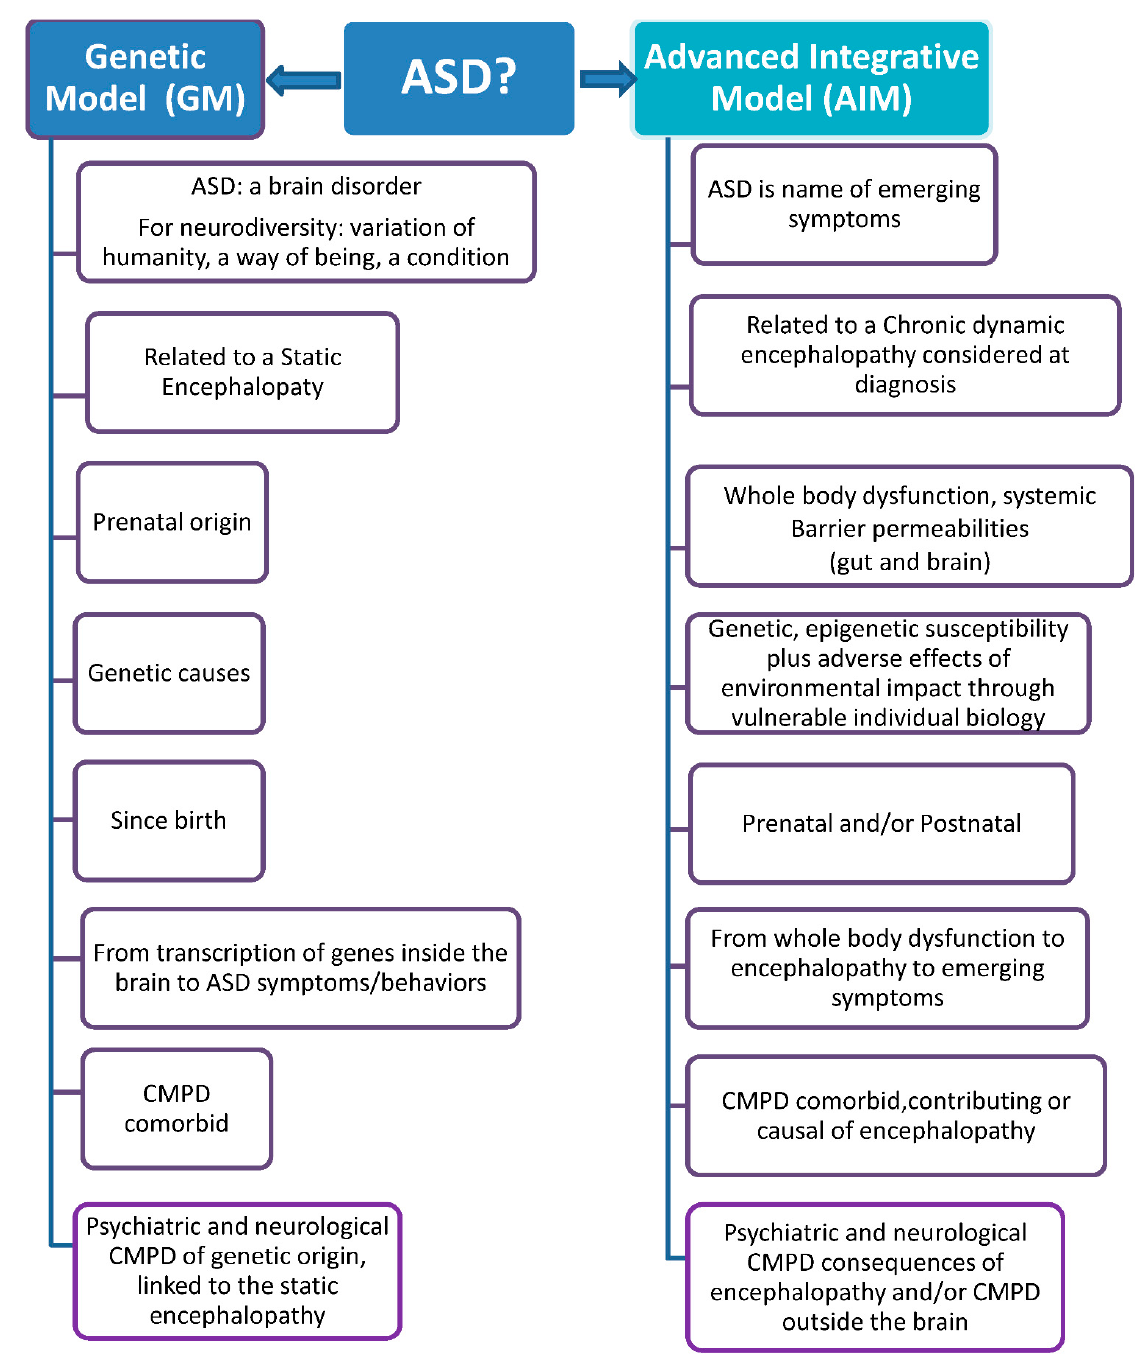
Figure 1. Genetic Model versus Advanced Integrative Model .